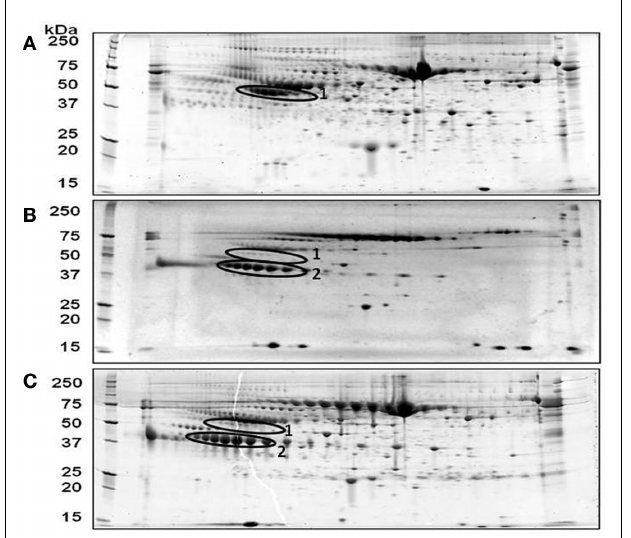
FIGURE 1 | Representative two-dimensional PAGE gel images of mouse plasma proteins following pulmonary F. tularensis challenge. Two-dimensional PAGE analysis was carried out as described under Section “Materials and Methods” using 3-day post challenge plasma. (A) Mock (PBS-treated) control; (B) F. tularensis LVS; (C) F. tularensis (type A) SCHU S4. Encircled area 1, α 1 -antitrypsin, encircled area 2, haptoglobin ( β